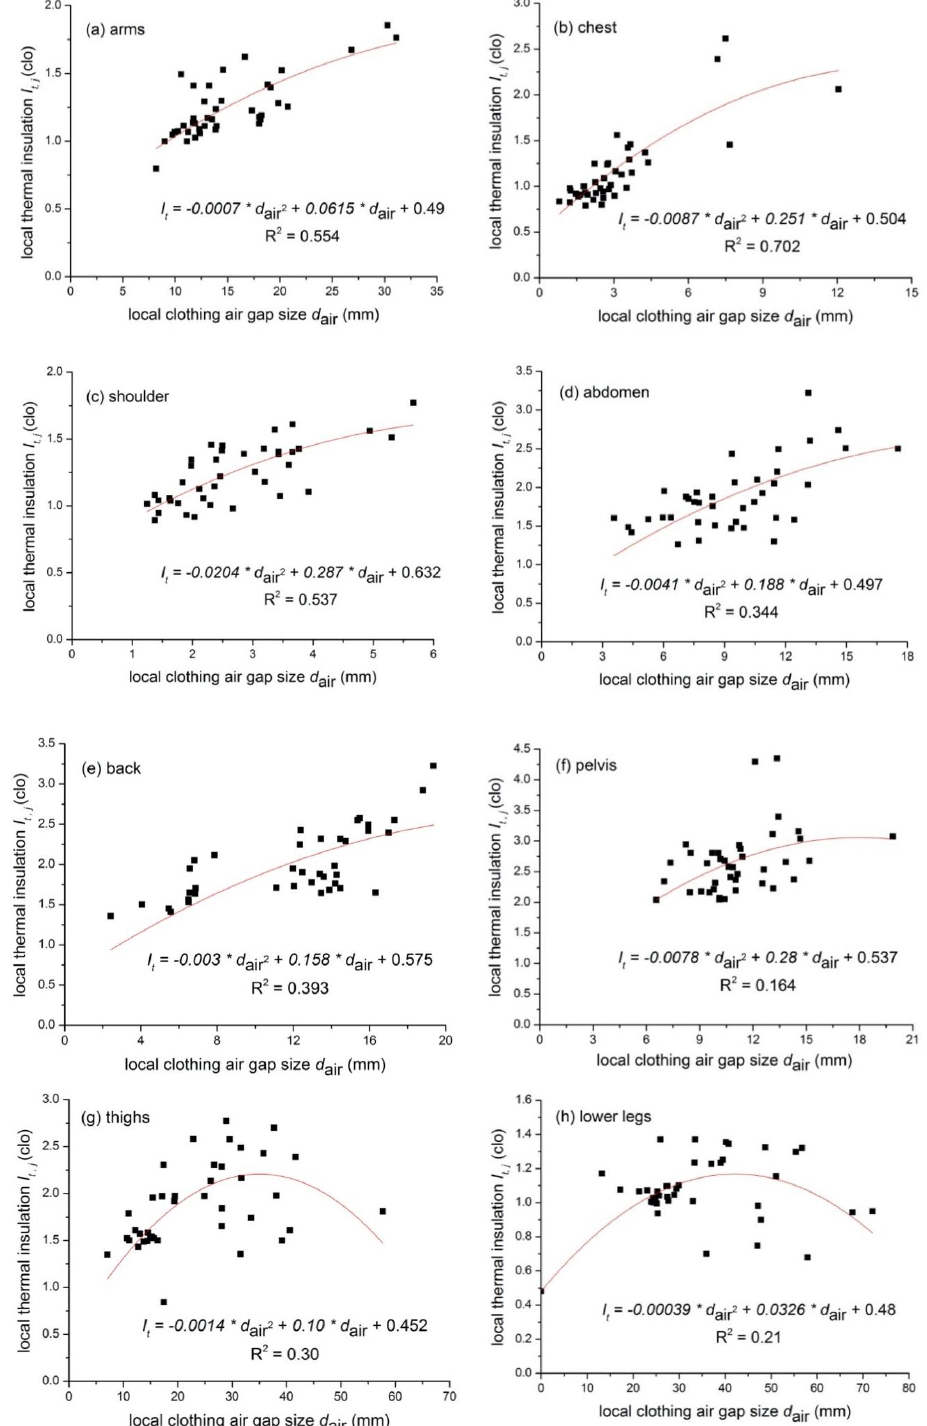
Figure 5. Relationships between the local I cl and the local d air for different body parts. ( a ) arms; ( b ) chest; ( c ) shoulders; ( d ) abdomen; ( e ) back; ( f ) pelvis; ( g ) thighs; and ( h ) lower legs.